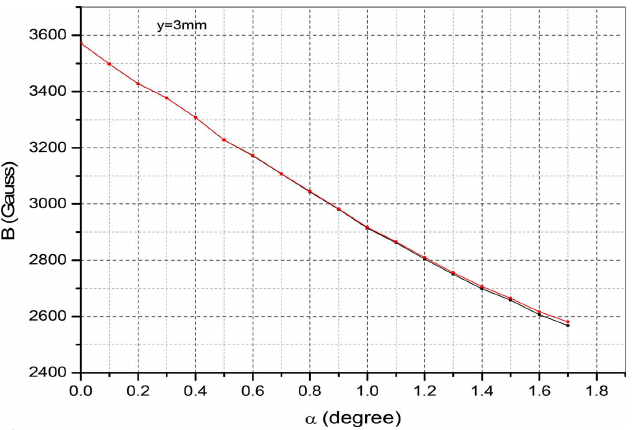
Figure 16 Effects of the tilt on the vertical field.